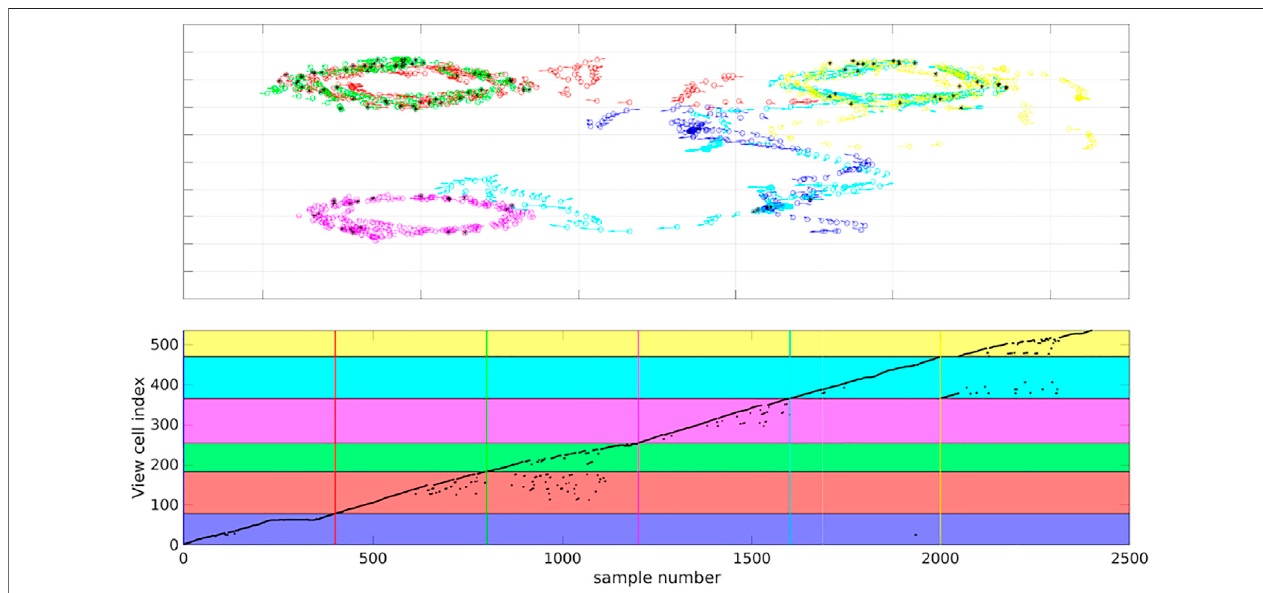
FIGURE 10 | View-cell memory sequentially presented with representations generated from all 6 simulated test sets to associate poses with proximal representations.Toppanel)ColourcodedquiverplotsofgroundtruthposesofthesimulatedWhiskEyeheadduringeachofthe6testsets(1 (cid:1) blue,2 (cid:1) red,3 (cid:1) green,4 (cid:1) magenta, 5 (cid:1) cyan and 6 (cid:1) yellow). The black asterisks indicate samples which triggered a re-localisation event in the view-cell memory, i.e., the representation of that sample was close to a previous representation stored in the view-cell memory. Lower panel) Graph of view-cell index against sample number from the concatenated 6 test sets ( n (cid:1) 2,400). The coloured horizontal bars highlight the region within the view-cell memory that store representations encountered during a particulartestset(colourmatchedtotestsets).Theverticalcolouredlinessetthestartofeachnewregionintheview-cellmemory.Re-localisationeventsaremarkedbya step decrease in view cell index between samples, signi fi cantly, samples from test set 3 are triggering re-localisation events that reference to view-cells created in test set 2.